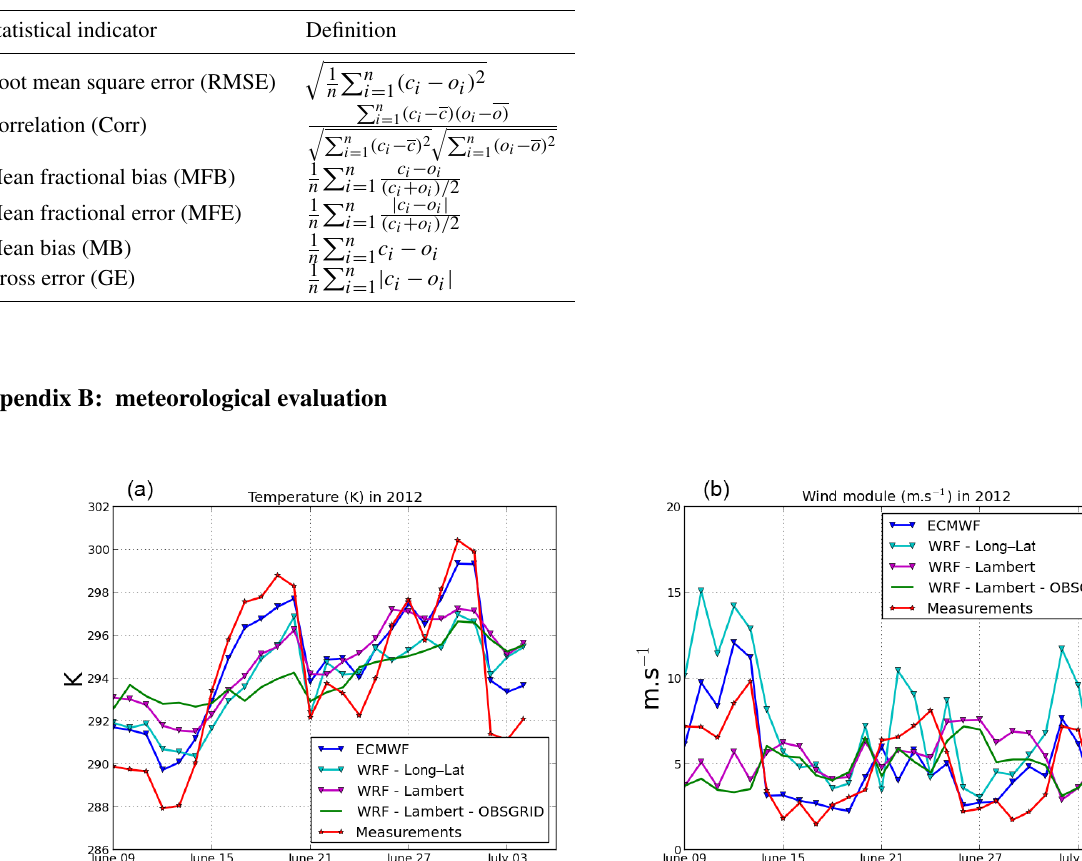
Table A1. Definitions of the statistics used in this work. (o i ) i and (c i ) i are the observed and the simulated concentrations at time and location i, respectively. n is the number of data.